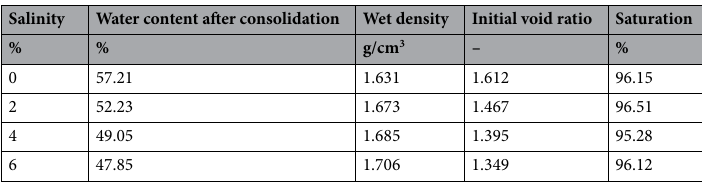
Table 3. Initial index properties of soil specimens.